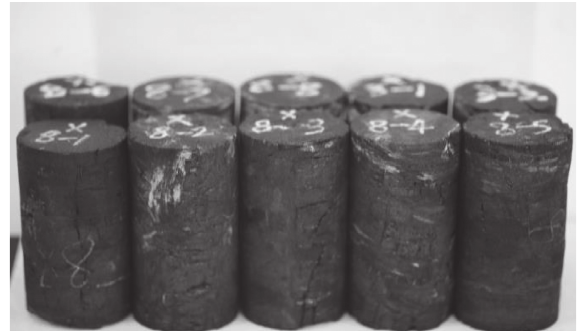
Figure 1: Physical map of coal rock.